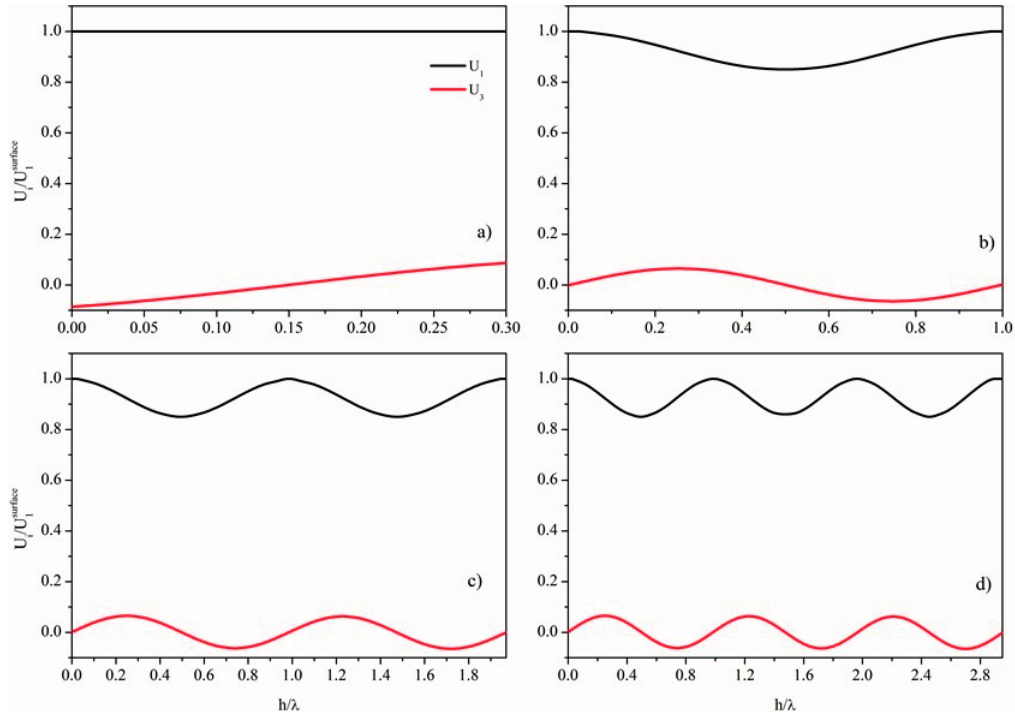
Figure 2. Cross sectional normalized distribution of normal (U 3 ) and longitudinal (U 1 ) displacements for: ( a ) AM propagating along the BN plate with h BN / λ = 0.3; ( b ) S 1 mode for h BN / λ = 1; ( c ) S 2 mode for h BN / λ = 1.97; ( d ) S 3 mode for h BN / λ = 2.95.